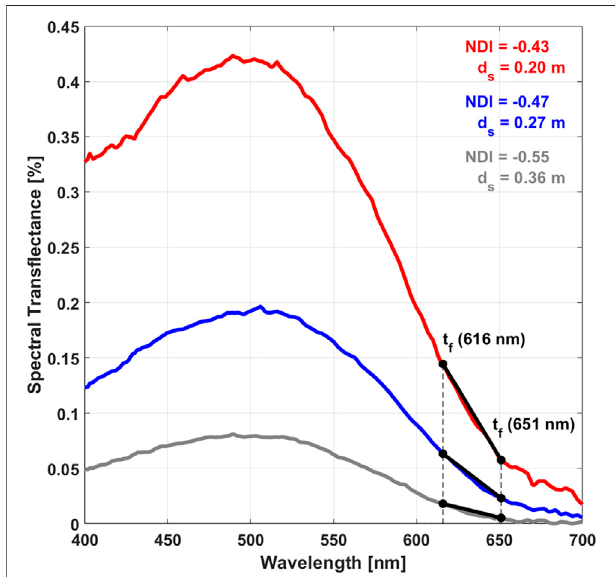
FIGURE 3 | Spectral trans fl ectance in % for three different snow depths d s of 0.20 m (red), 0.27 m (blue), and 0.36 m (grey). NDIs ( Eq. 1 ) are given in numbers to indicate the different slopes of the trans fl ectance t f between 651 nm and 616